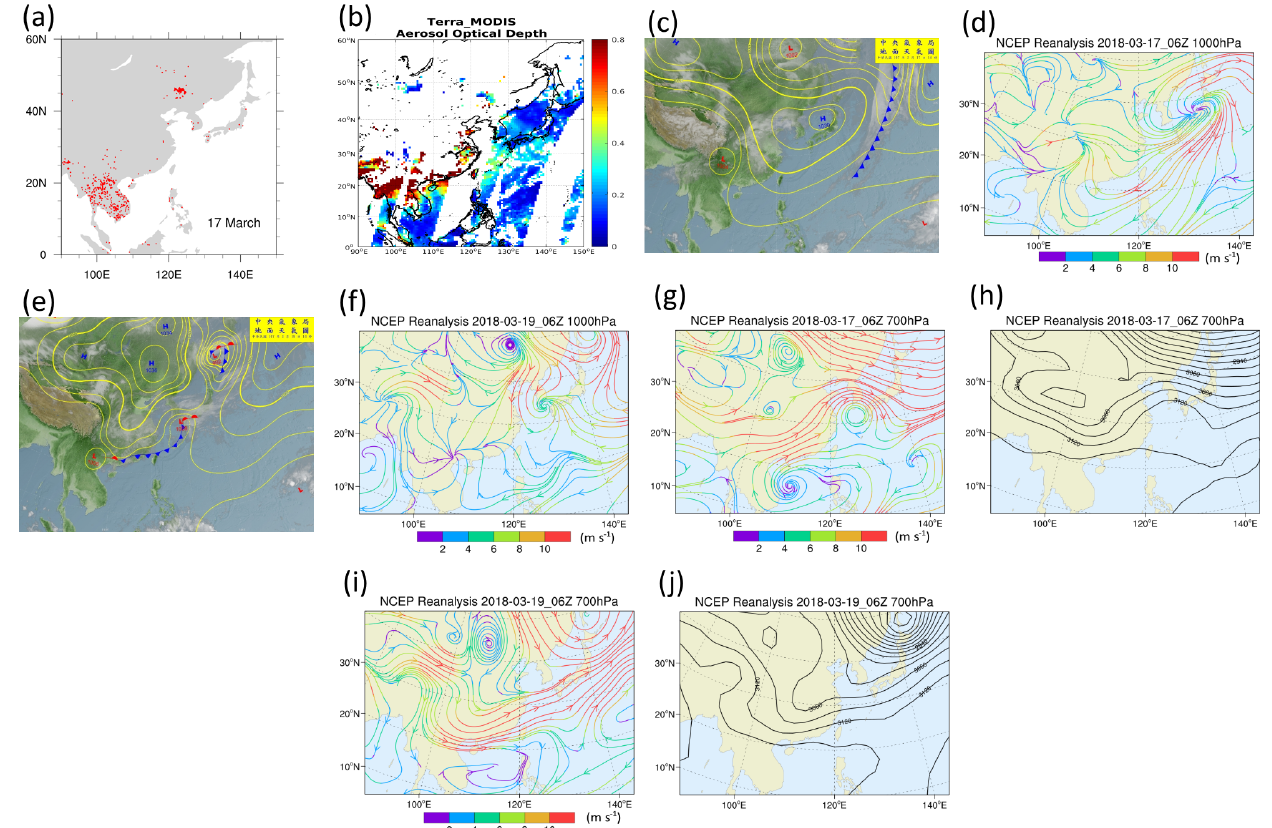
Figure 2. (a) MODIS fire hotspots on 17 March 2018 (source: https://modis-fire.umd.edu/guides.html, last access: 14 February 2023) and (b) composited aerosol optical depth (AOD) from MODIS on board NASA’s Terra satellite. The collection 6.1 AOD is downloaded from NASA’s Earthdata website (https://www.earthdata.nasa.gov/learn/find-data, last access: 14 February 2023) and composted for 01:10, 01:15, 01:20, 01:25, 01:30, 02:50, 02:55, 03:00, 03:05, 03:10, 04:30, 04:35, 04:40, 04:45, 06:10, 06:15, 06:20, 07:45, and 07:50UTC data granules on 17 March 2018. (c) Weather chart at 06:00UTC on 17 March 2018, (d) 1000hPa streamlines at 06:00UTC on 17 March 2018, (e) and (f) are the same as (c) and (d) but on 19 March 2018, (g) 700hPa streamlines at 06:00UTC on 17 March 2018, (h) 700hPa geopotential height at 06:00UTC on 17 March 2018, (i) and (j) are the same as (g) and (h) but on 19 March 2018. Near-surface weather charts and satellite images were provided by the Central Weather Bureau (CWB), Taiwan. The near-surface and 700hPa streamlines and geopotential height were deduced from NCEP Reanalysis data. Maps and plots were produced using the NCAR Command Language (NCL) version